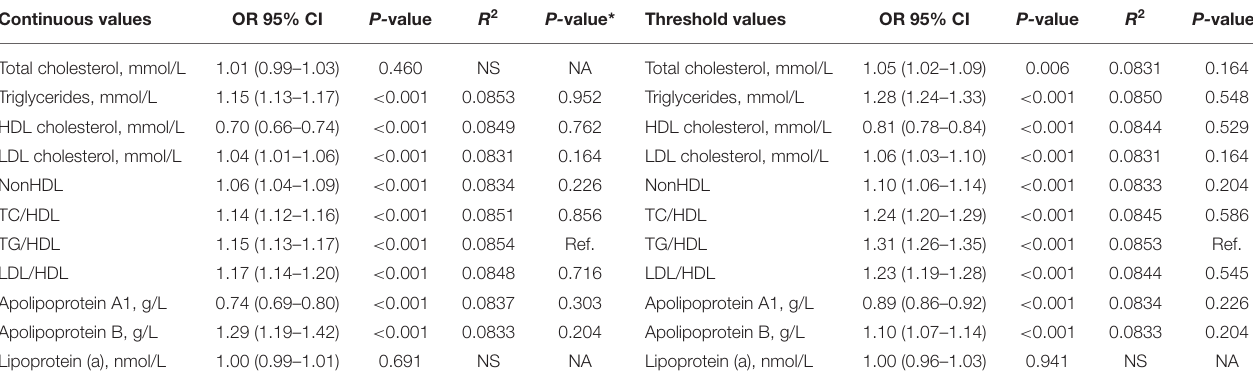
TABLE 6 | Multiple logistic regression models for arterial stiffness (defined as ASI > 10 m/s) with each lipid parameter in continuous values and in threshold cutoffs. Continuous